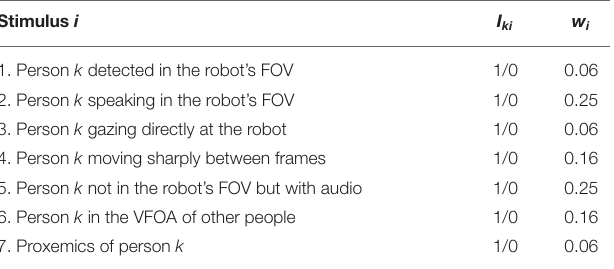
TABLE 1 | Weights in stimuli calculations (obtained with the optimization problem). Stimulus